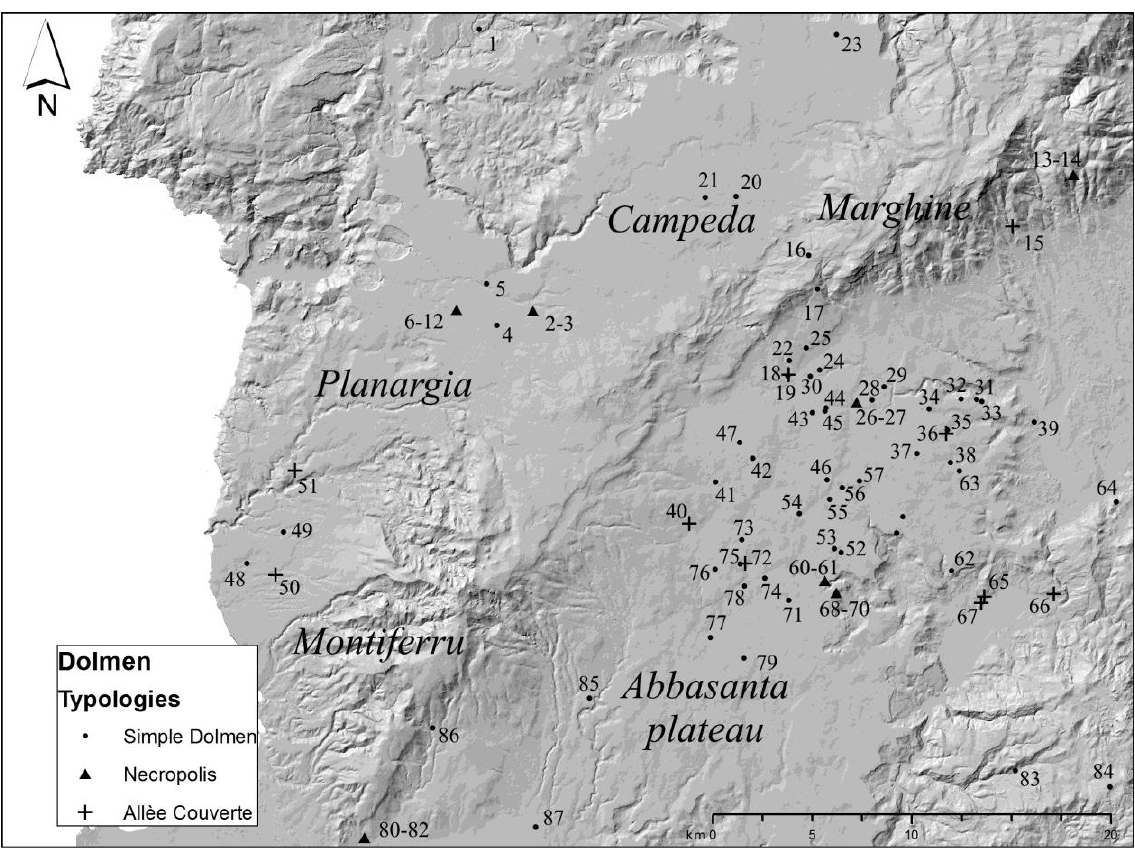
Figure 3. Map of distribution of the examined dolmens: 1. San Sebastiano-Padria; 2. Nela I-Sindia; 3. Nela II- Sindia; 4. Serrese-Sindia; 5. Furrighesu-Sindia; 6. Matta Larentu I-Suni; 7. Matta Larentu II-Suni; 8. Matta Larentu III-Suni; 9. Matta Larentu IV-Suni; 10. Matta Larentu V-Suni; 11. Matta Larentu VI-Suni; 12. Matta Larentu VII-Suni; 13. Tanca Noa A-Bolotana; 14. Tanca Noa B-Bolotana; 15. S. Basilio-Lei; 16. Tuide- Bortigali; 17. Carrarzu Iddia-Bortigali; 18. Sa Perda 'e S'Altare-Macomer; 19. Tanca Sa Marchesa-Macomer; 20. Su Edrosu-Macomer; 21. Terra Tenera-Macomer; 22. Bidui-Macomer; 23. Aeddo-Macomer; 24. Sa Tanca Sar Bogadas-Birori; 25. Noazza-Birori; 26. Arbu I-Birori; 27. Arbu II-Birori; 28. Corrizzola-Birori; 29. Mura Pranosa-Birori; 30. Pradu Lassia-Birori; 31. Sa Fronte Uda-Dualchi; 32. Mazzarighe A-Dualchi; 33. Mazzarighe B-Dualchi; 34. Lughe-Dualchi; 35. Badde Ide-Dualchi; 36. Brancatzu-Dualchi; 37. Paule Rues-Dualchi; 38. Baratta-Dualchi; 39. Baccarzos-Noragugume; 40. Pedra in Cuccuru-Borore; 41. Giuanne Pedraghe-Borore; 42. Muttianu-Borore; 43. Sa Matta e sa Ide-Borore; 44. Serbine A-Borore; 45. Serbine B-Borore; 46. Arghentu- Borore; 47. Su Narbanu-Borore; 48. Monte Lacana-Cuglieri; 49. Su Livrandu-Cuglieri; 50. Su Lizu-Cuglieri; 51. Sa Cobelcada-Sennariolo; 52. Succhiau-Aidomaggiore; 53. Mura Fratta-Aidomaggiore; 54. Tuvamene- Aidomaggiore; 55. Nucrastala-Aidomaggiore; 56. Meddaris-Aidomaggiore; 57. Su Nuradorzu-Aidomaggiore; 58. Scarallotza-Aidomaggiore; 59. Crobecada-Aidomaggiore; 60. S’Aspru I-Aidomaggiore; 61. S’Aspru II- Aidomaggiore; 62. Iloi-Sedilo; 63. Lure-Sedilo; 64. Filigorri-Sedilo; 65. Monte Trigu-Sedilo; 66. Torozzula- Sedilo; 67. Monte Paza-Sedilo; 68. Nurarchei A-Norbello; 69. Nurarchei B-Norbello; 70. Nurarchei C-Norbello; 71. Abbamuru-Norbello; 72. Sa Perda Piccada-Norbello; 73. Sa Codina 'e S'Ispreddosu-Norbello; 74. Mura 'e Iscovas-Norbello; 75. S'Angrone-Abbasanta; 76. Mesu Enas-Abbasanta; 77. Cannigheddu 'e S'Ena-Abbasanta; 78. Mura 'e Putzu-Abbasanta; 79. Su Nuratzolu-Abbasanta; 80. Carrazzu I-Narbolia; 81. Carrazzu II-Narbolia; 82. Carrazzu III-Narbolia; 83. S. Maria di Olisai-Neoneli; 84. Nole-Neoneli; 85. Serra Crastula-Bonarcado; 86. Serra Passa-Seneghe; 87. Su Conzau de Is Froris Grogus-Milis (Elaboration of the